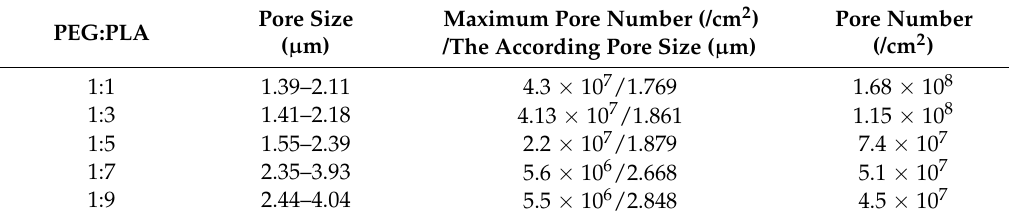
Table 4. Contact angles of PLA/PEG/Cur CNFMs with different weight ratios (PEG:PLA). Ratio